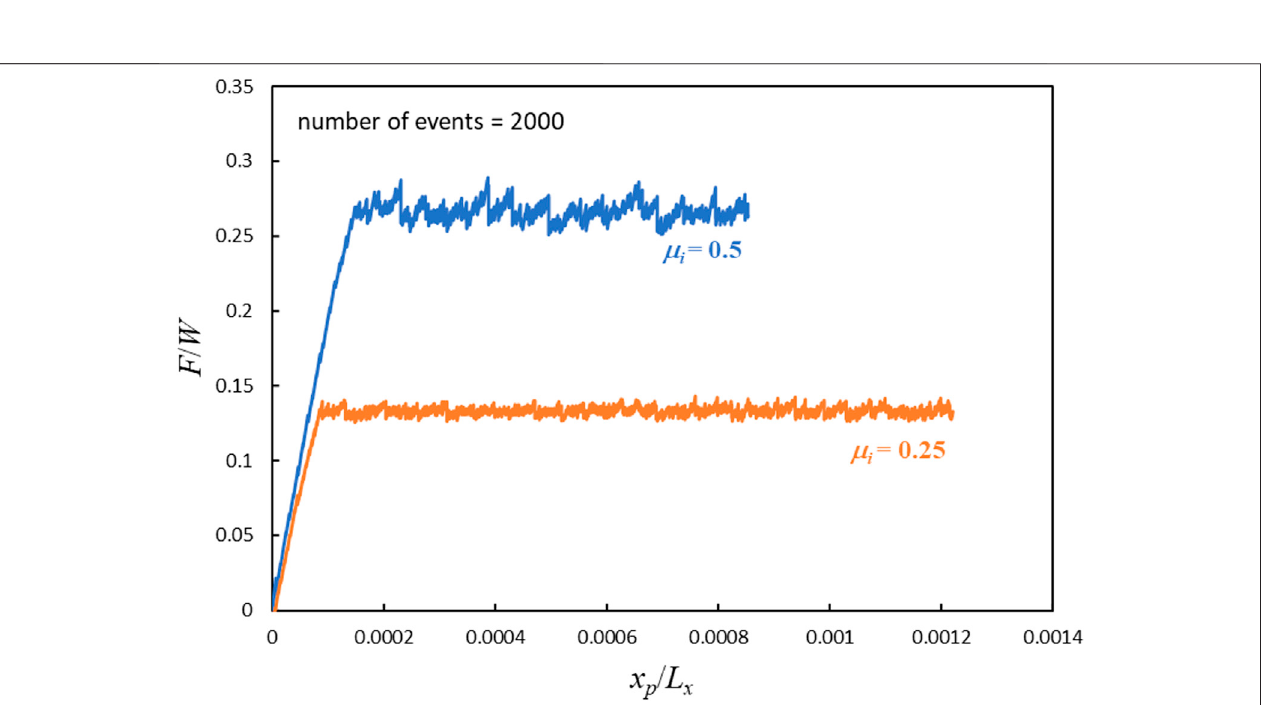
FIGURE 6 | Normalized, nanometer-scale friction force (friction force over normal force) as a function of dimensionless horizontal pin displacement.